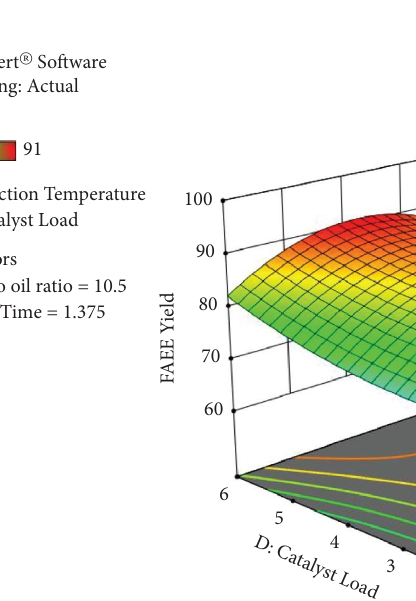
Figure 8: Te interaction impact of the reaction temperature and catalyst load versus yield of FAEE (%) (own fgure).